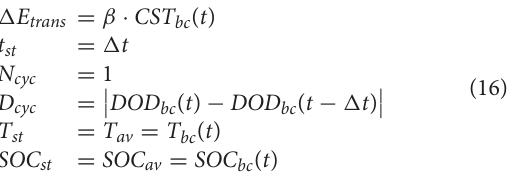
Figure 3 indicates the degradation vs. DoD curve. For example,